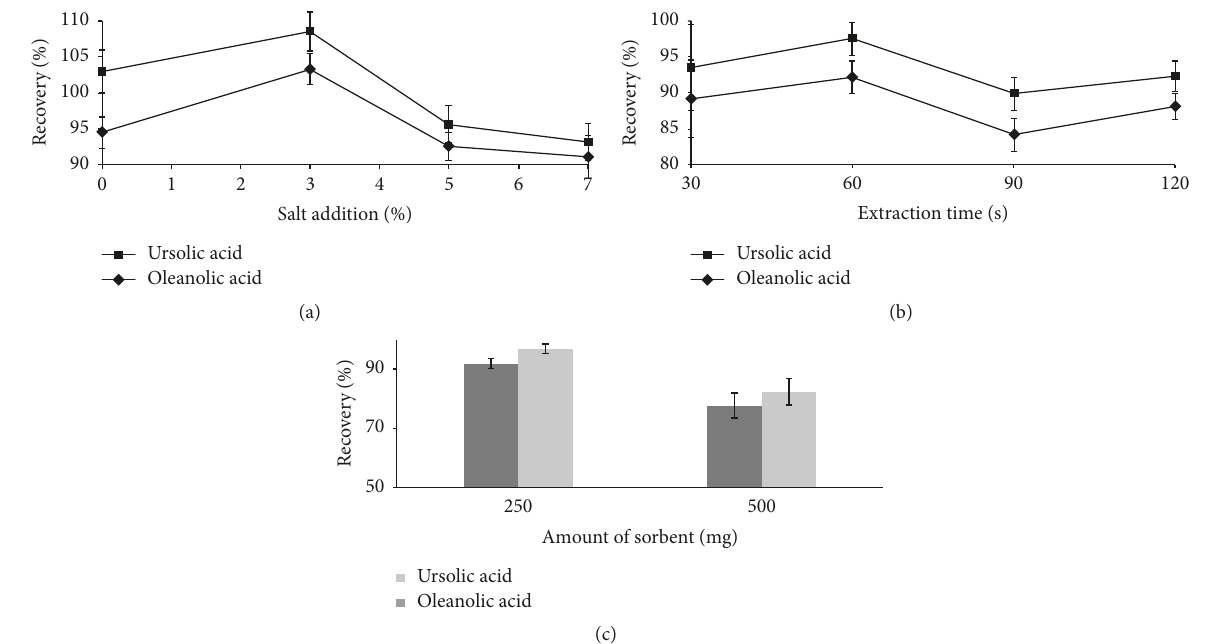
Figure 2: Effect of salt addition (a), extraction time (b), and sorbent amount (c) on the QuEChERS-based extraction of standard solutions.